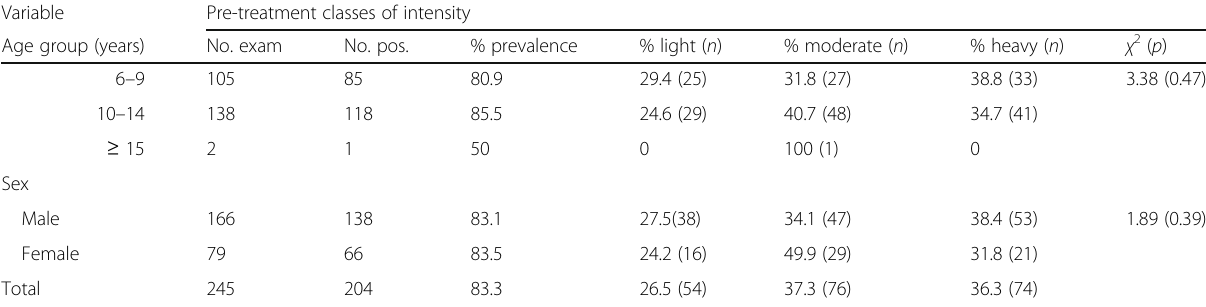
Table 2 Pre-treatment prevalence (%) and proportion of classes of S. mansoni infection by age group and sex in Sanja General Elementary School children, Sanja town, Tacharmachiho district, Northwest Ethiopia, from March to April 2017